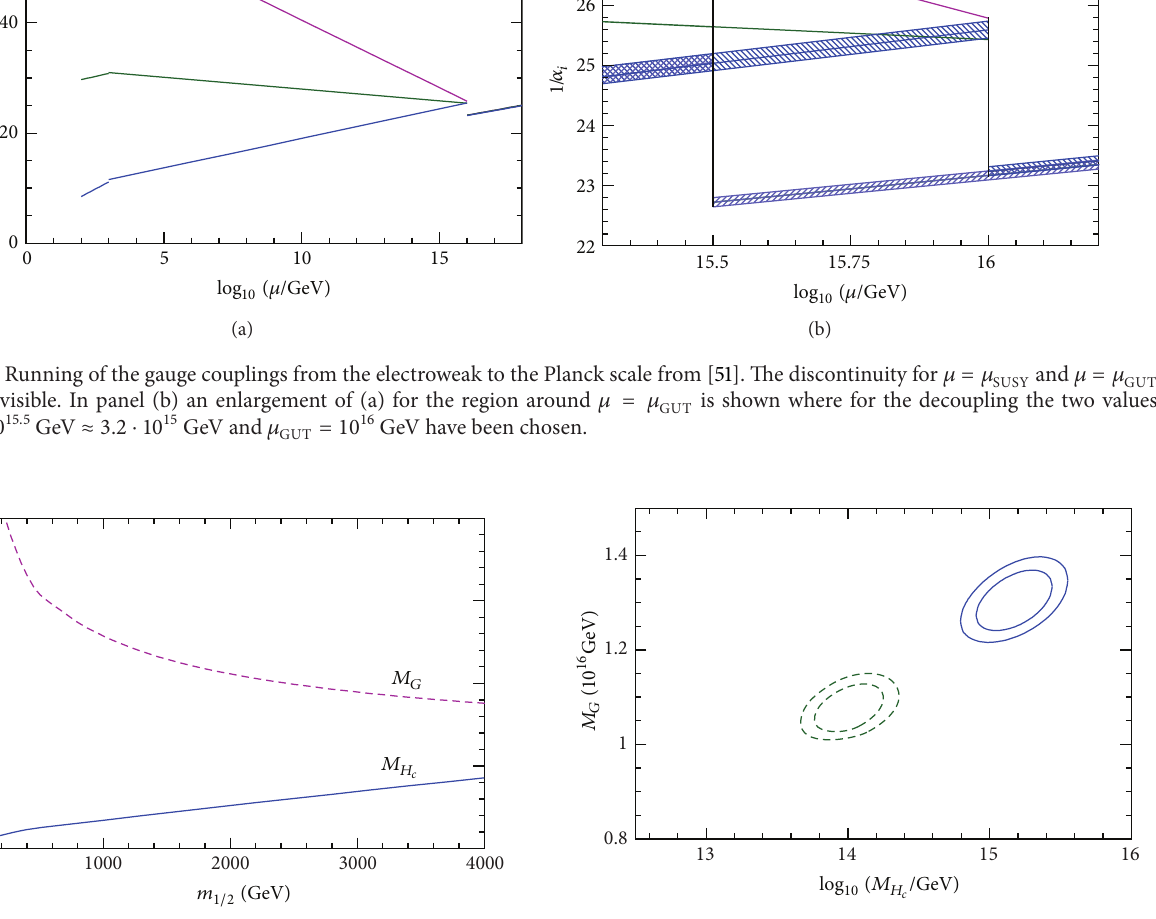
Figure 9: Ellipses in the 𝑀 𝐻 - 𝑀 𝐺 plane obtained from the uncer- 𝑐 tainties of the gauge coupling sat the electroweak scale. The input parameters of (130) have been used whereas 𝛿𝛼 𝑠 = 0.0010 has been chosen. Dashed and solid lines correspond to the two- and three- loop analysis,